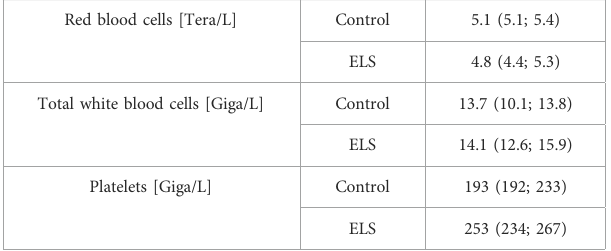
mortem brain tissue specimen as well as in the isolated PBMC and granulocytes. Overall, the measured parameters of mitochondrial respiratory activity did not differ between control and ELS animals (Table 5; Figure 3), except for signi fi cantly lower granulocyte routine respiration in the control pigs. Plotting